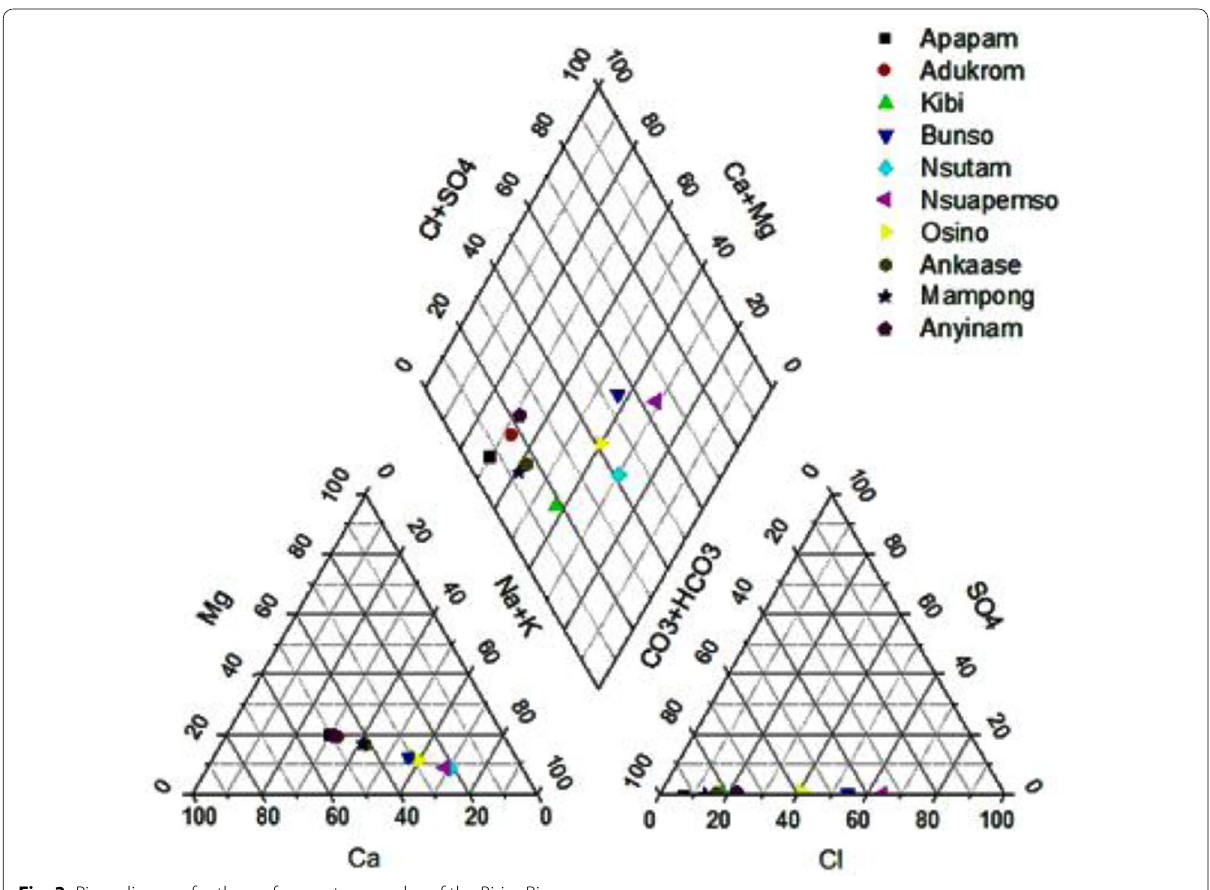
Fig. 3 Piper diagram for the surface water samples of the Birim River